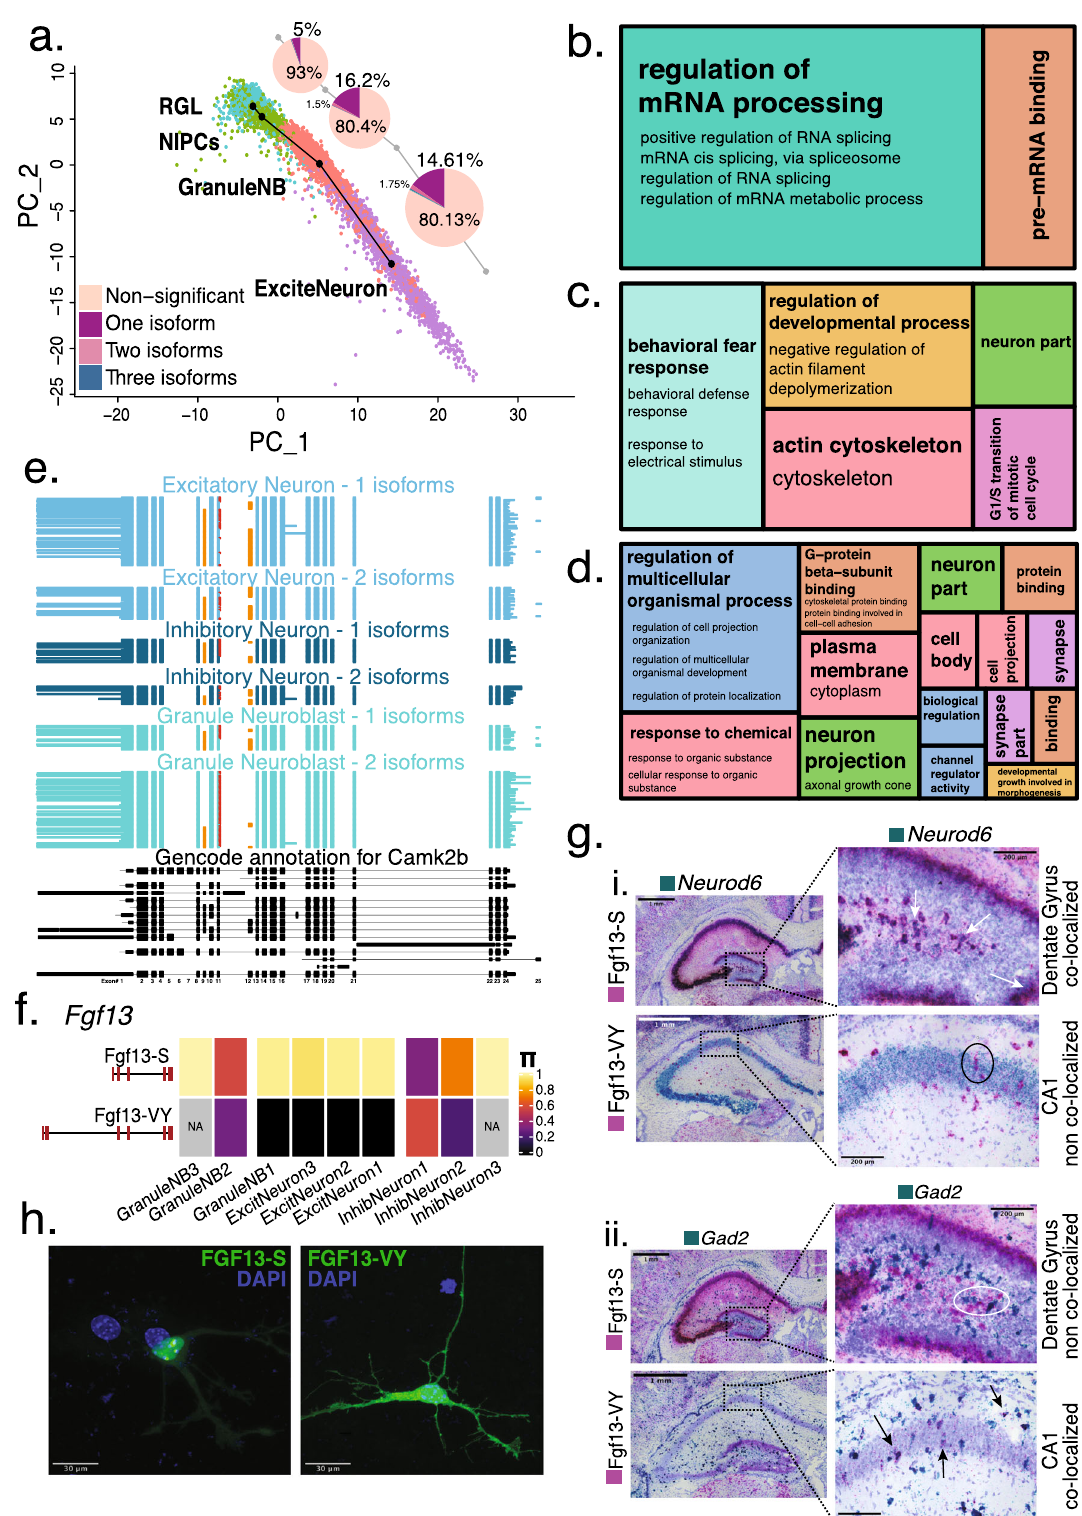
diversity of non-neuronal cells, or due to origins from different stem cell populations. Importantly, excitatory neurons and astrocytes which originate from the same stem cell population but are functionally distinct show high DIE (35.8%). However, the excitatory neuron population also shows high DIE with Cajal – Retzius cells (18%) despite both originating from different stem cell populations but functioning as neurons. Among the